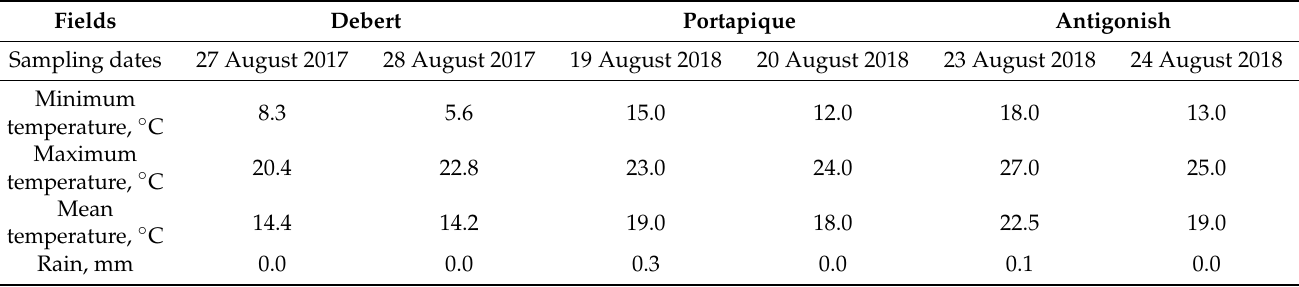
Table 2. Weather data for each of the sites and harvest dates used in this